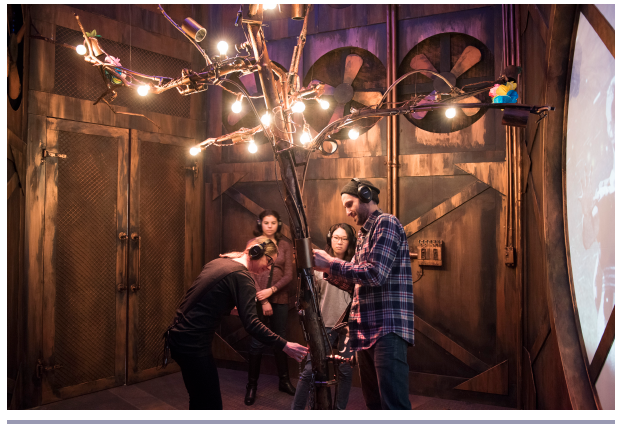
Fig. 5 . The materialist room. (Photo by Emily Cooper.)